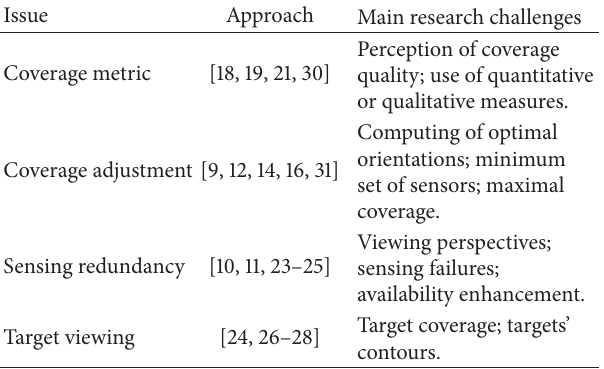
Table 1: Visual sensing coverage in wireless sensor networks.